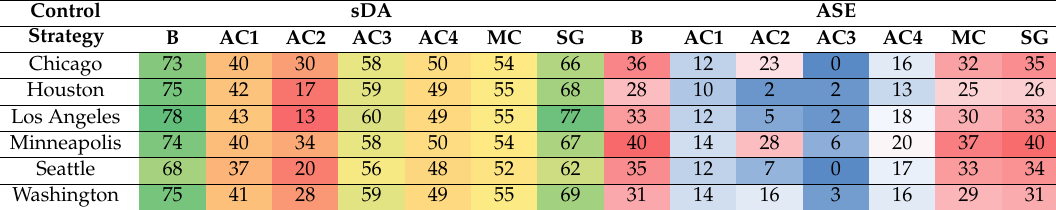
Table 2. Spatial daylight autonomy and annual sunlight exposure for di ff erent shading control strategies at six di ff erent